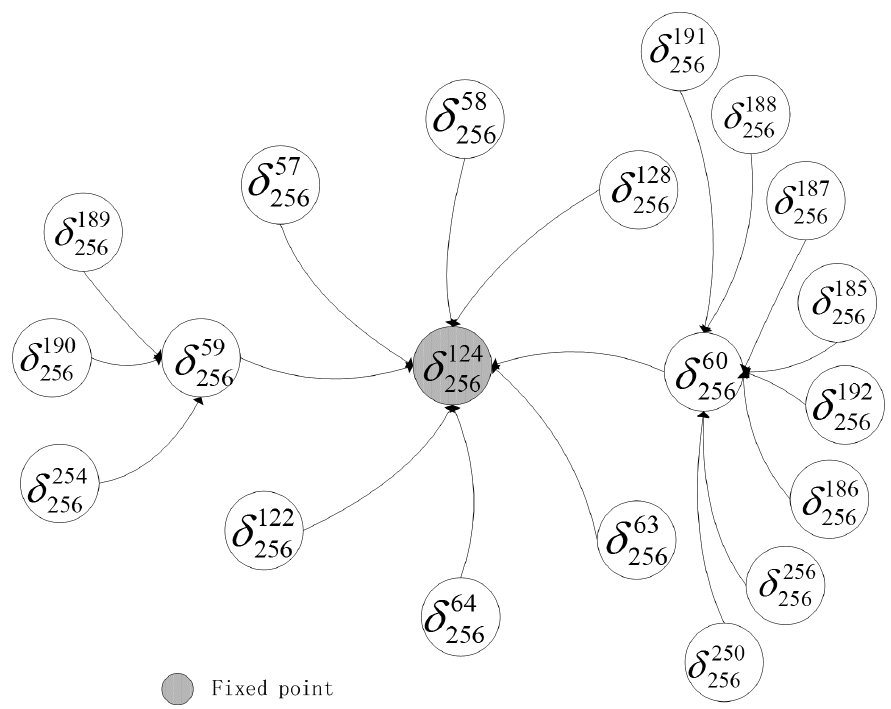
Figure 6. The basin of the fixed point under synchronous update.